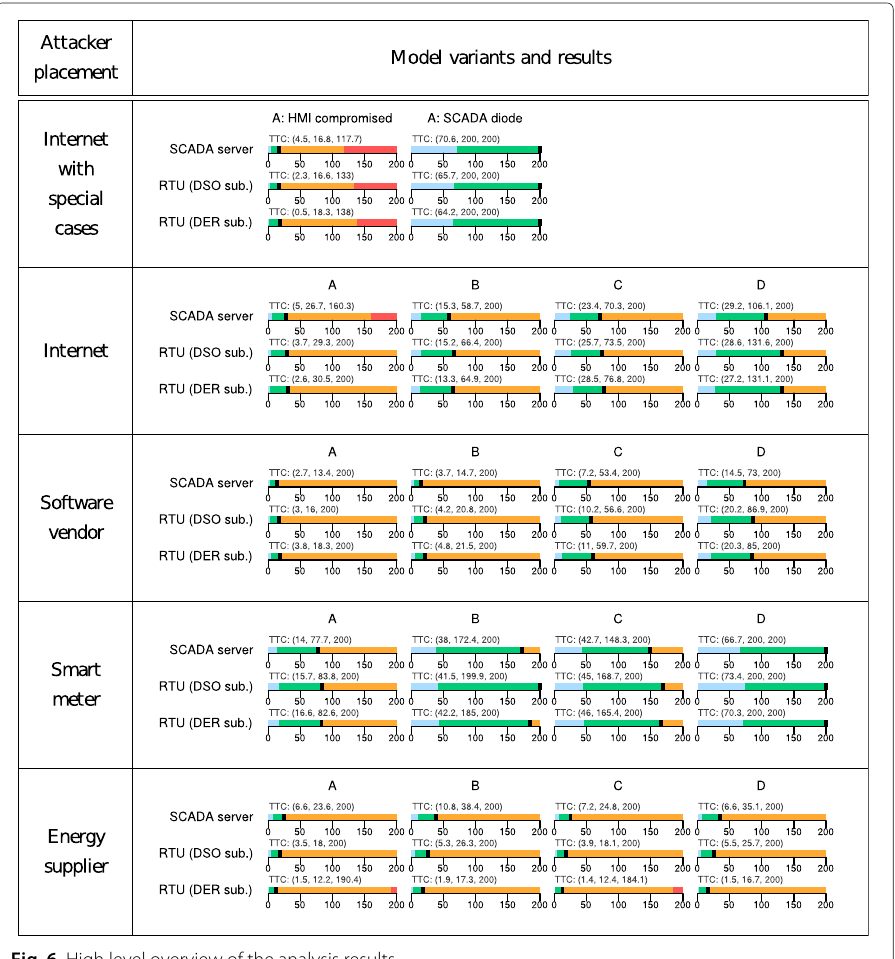
Fig. 6 High level overview of the analysis